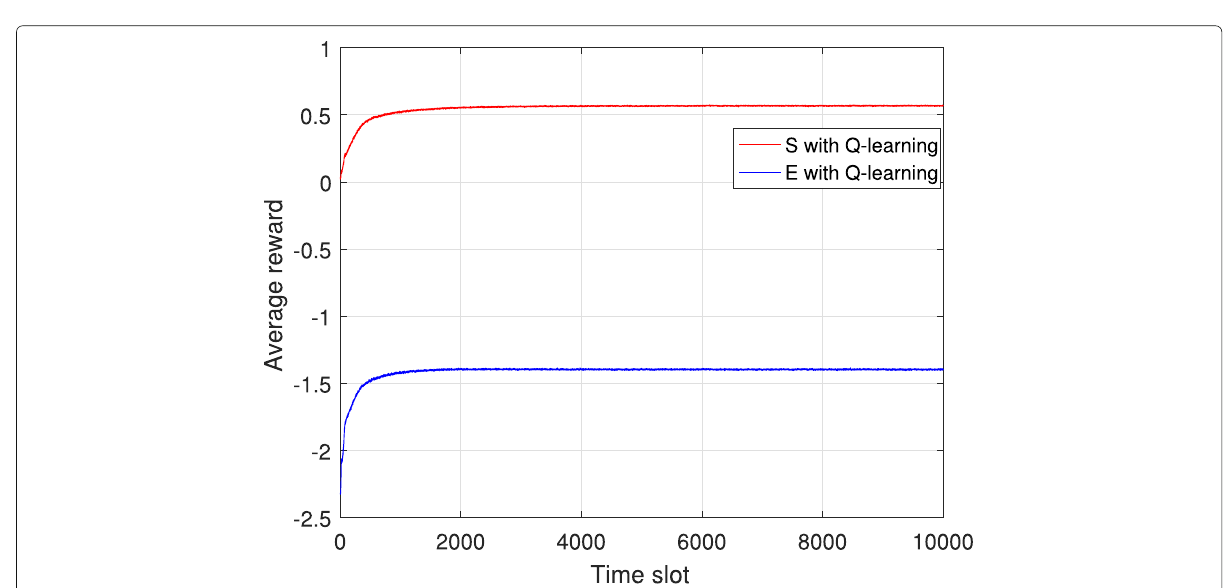
Fig. 2 The average reward of the power allocation